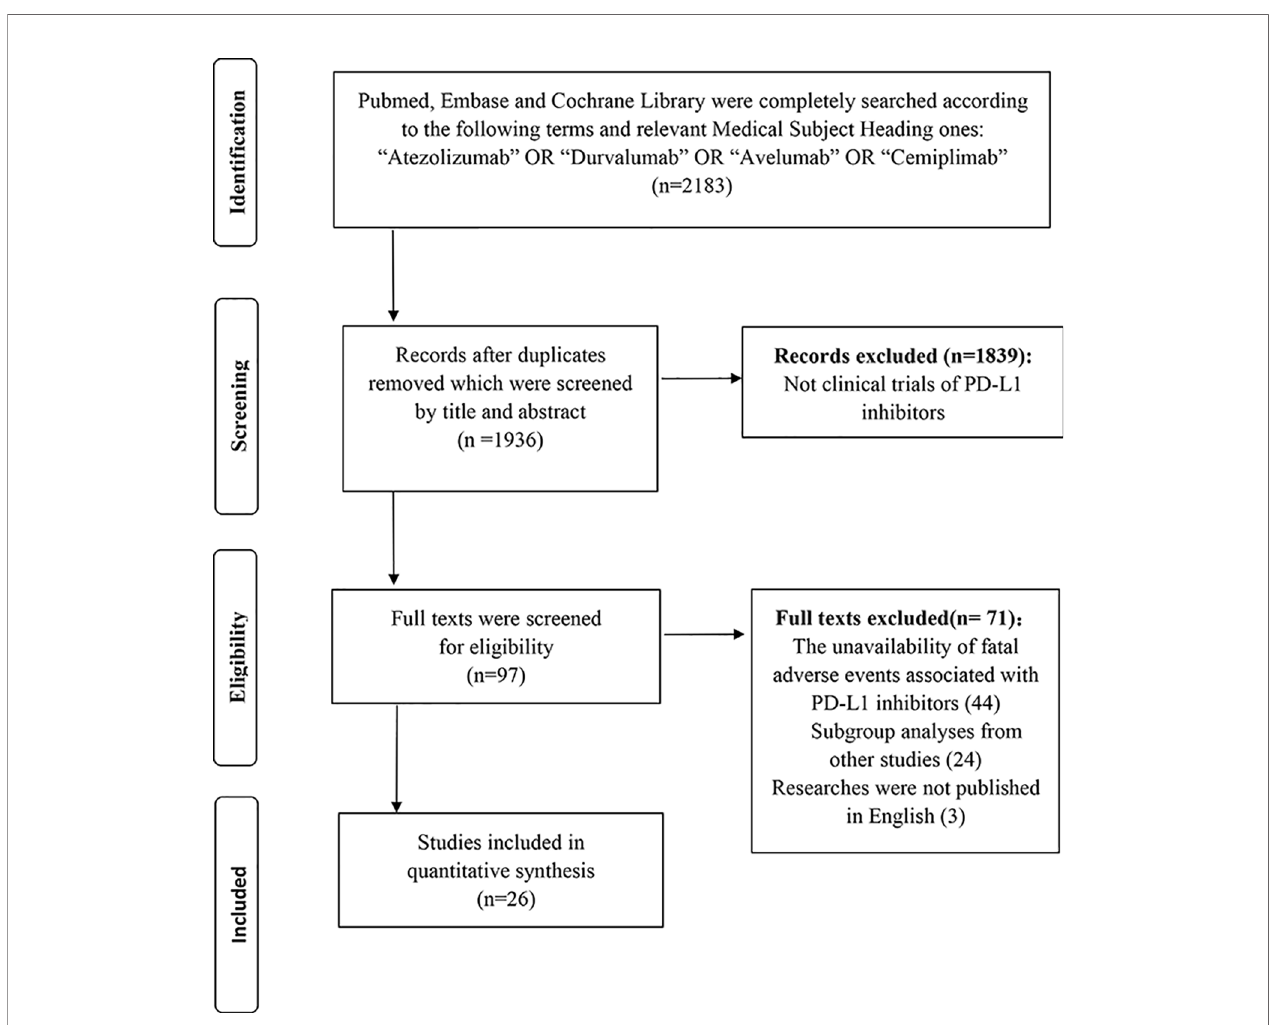
FIGURE 1 | Flow diagram of the